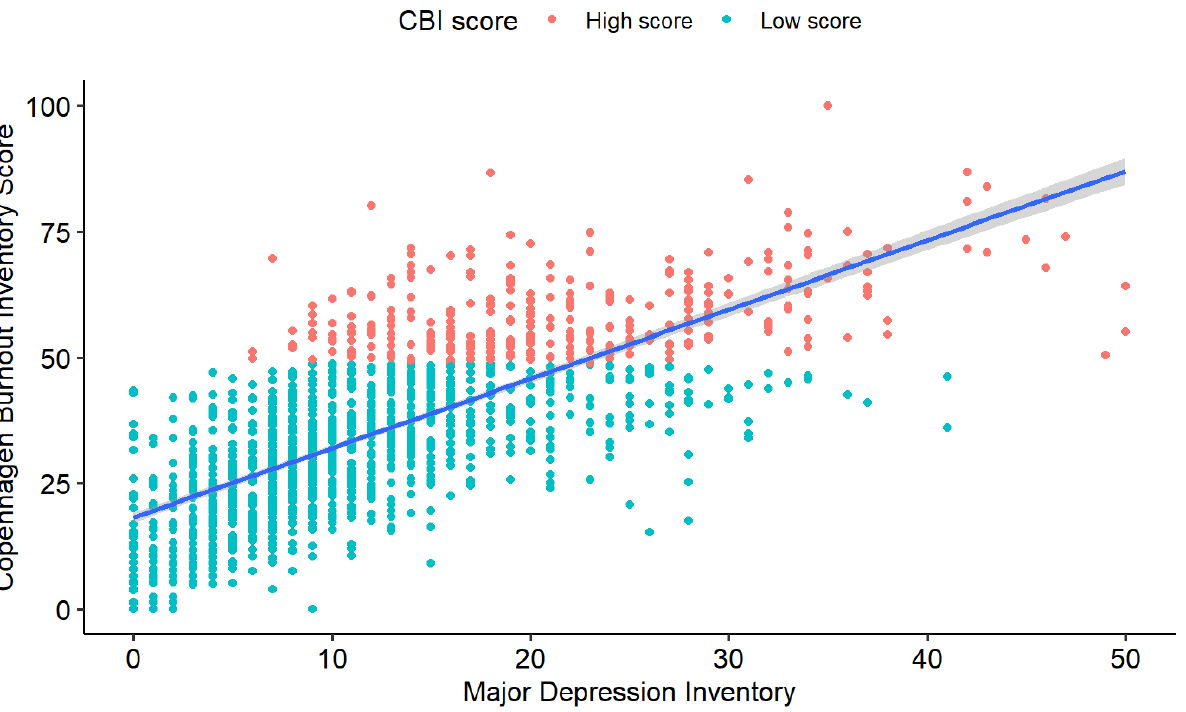
Figure 2. Correlation between Major Depression Inventory (MDI) score and Copenhagen Burnout Inventory (CBI) score among AI in REPAR study, (Linear R 2 = 0.52; p <